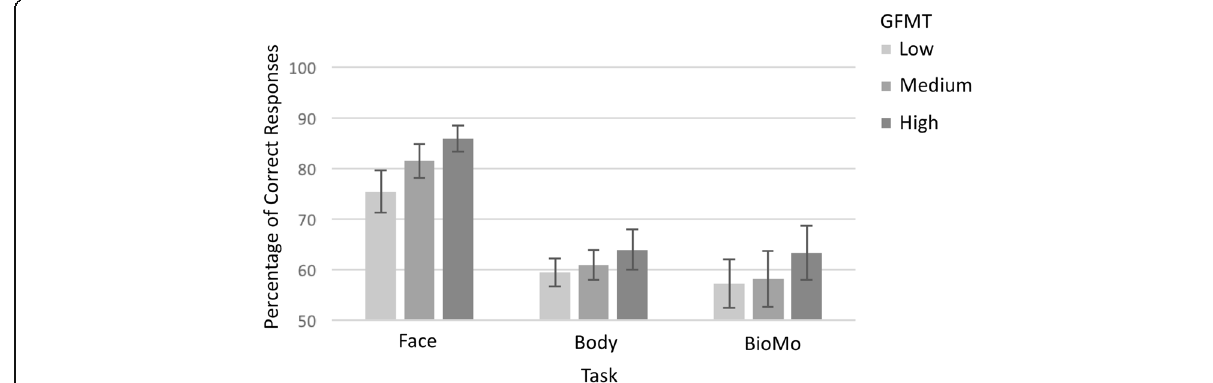
Fig. 6 Accuracy (% correct) on each task for each Glasgow Face Matching Test (GFMT) face-recognition-ability level (low face recognition, medium face recognition, high face recognition). Error bars show standard deviation from the